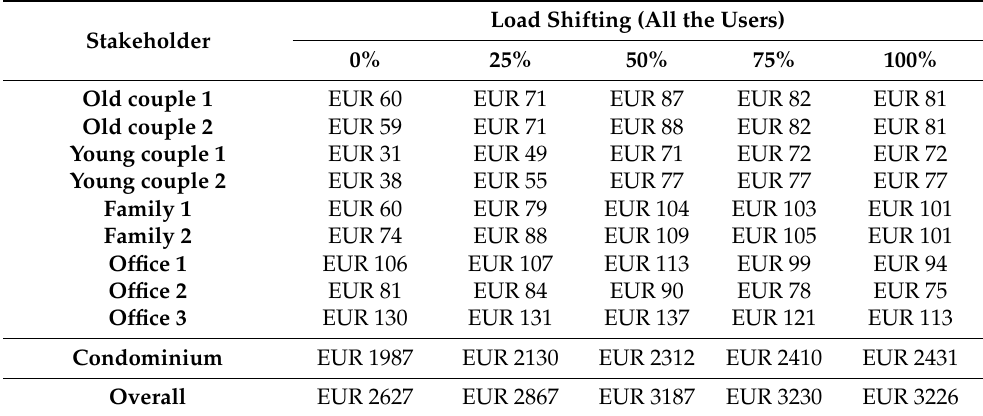
Table 10. Yearly revenue of each stakeholder of the configuration for Scenario B-EC, considering different levels of load shifting from all the users.